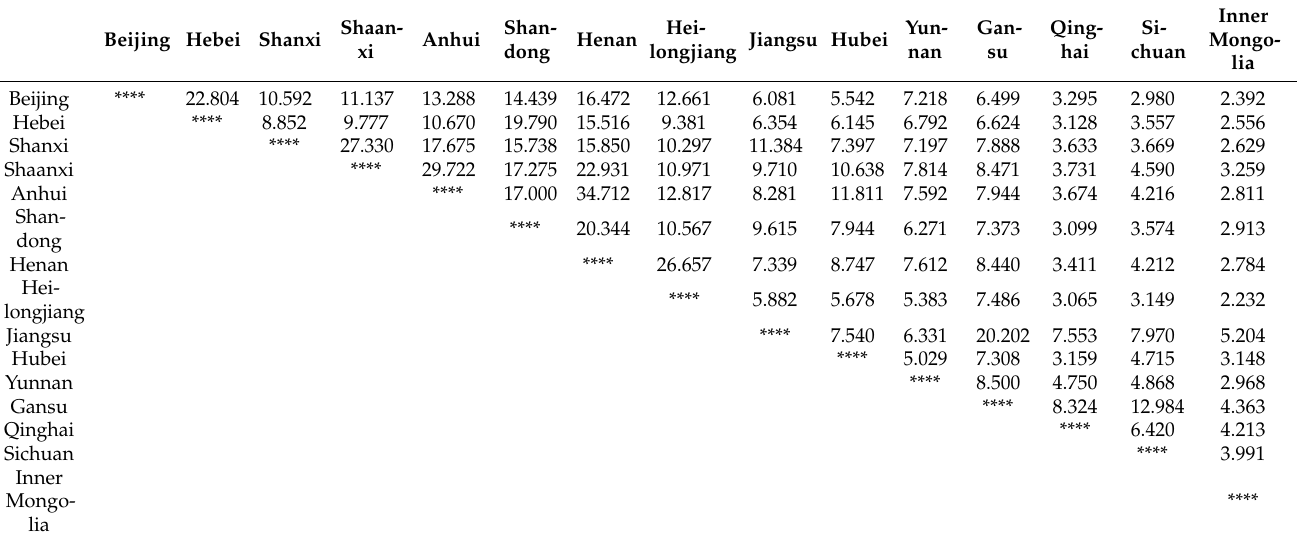
Table 4. The value of Nm between different pair of